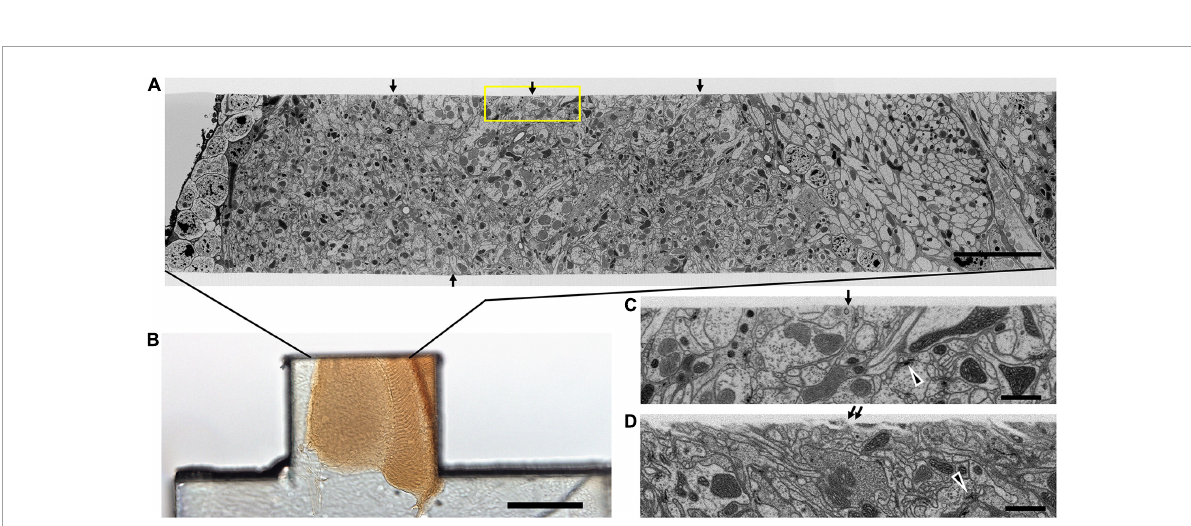
FIGURE6 Quality of the cut surface of hot-knife slice. (A) Entire FIB-SEM image of the medulla neuropile of a 20 µ m thick hot-knife slice shown in (B) . (B) Light micrograph of 20 µ m slice of optic lobe. (C) Enlarged area of one side of the cut surface, shown enclosed in yellow box in (A) . Arrows in (A) show the smoothness of the cut surface of the slice. Arrowhead in (C,D) shows selected synaptic profile. Arrows in (C,D) show the surface of the hot-knife slice, smooth (C) but occasionally rough (D) . Scale bars: 10 µ m (A) ; 100 µ m (B) ; 1 µ m (C,D)